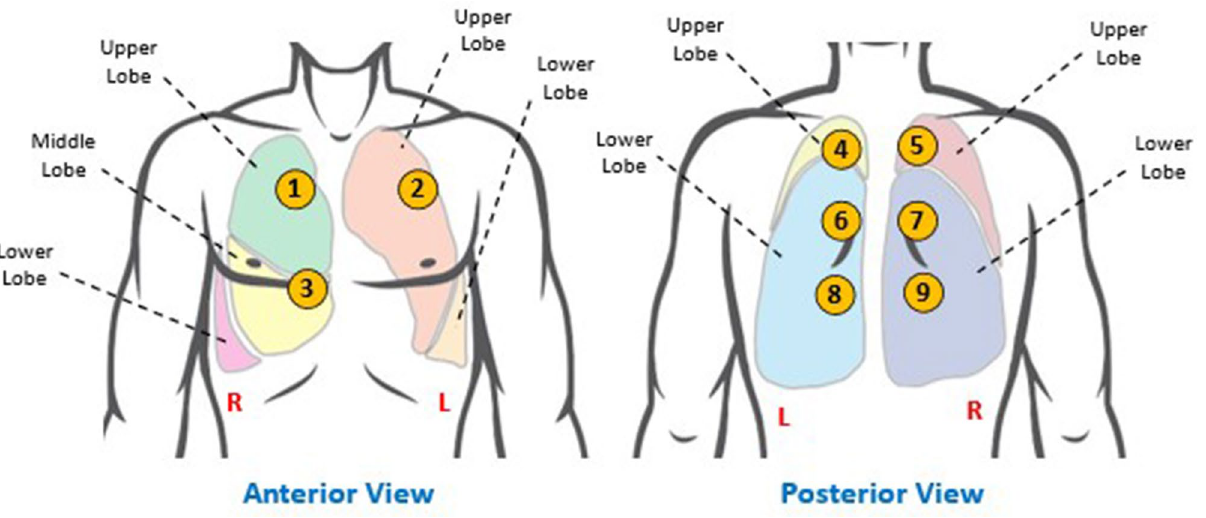
Figure 2. Anatomy of the lungs and auscultation sites. The anterior and posterior view of the body illustrating the location of various lung lobes. Areas numbered 1 through 9 indicate the auscultation sites used for data recording from patients. The locations are chosen to examine majority of the lung area during the